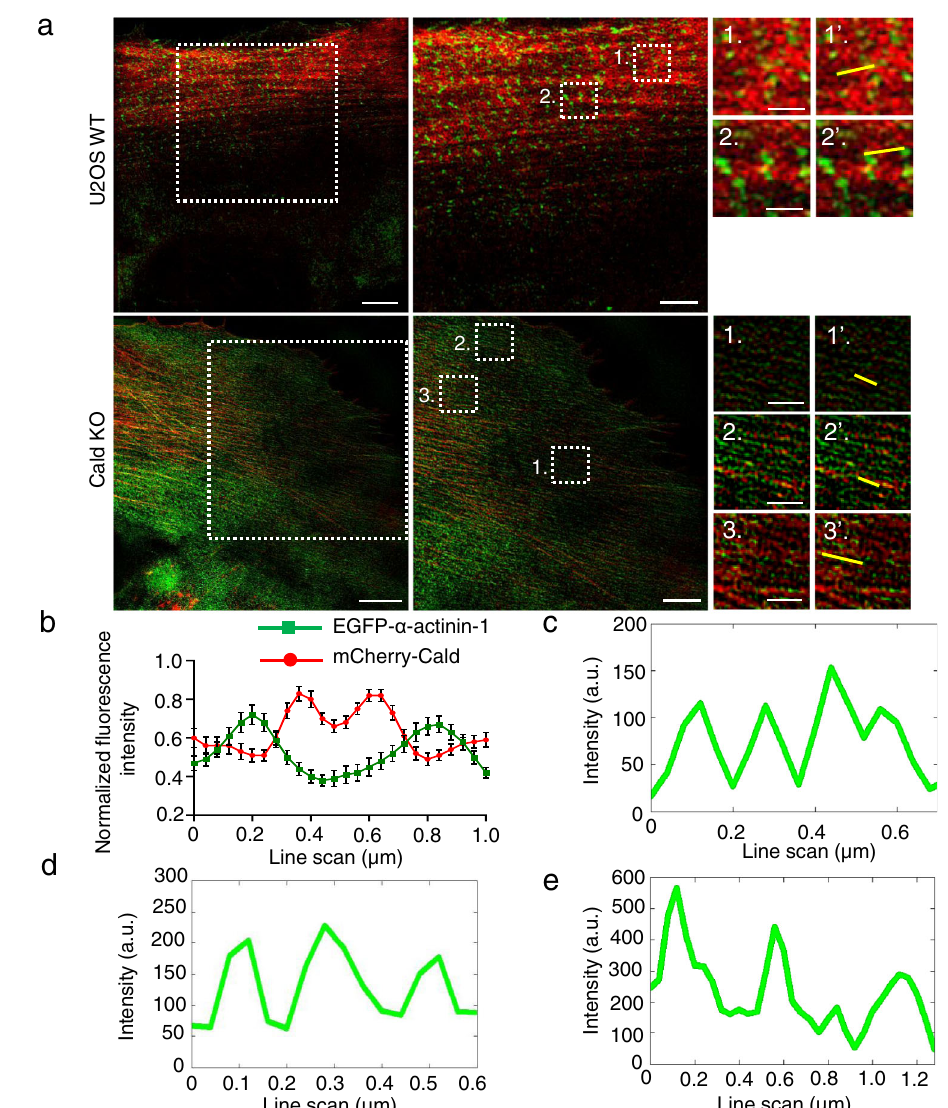
Fig. 7 | Effects of Caldesmon depletion on α -actinin localization along stress fi bers. a Representative SIM image of a wild-type U2OS cell (top row) expressing GFP- α -actinin (green) and mCherry-Caldesmon (red). White boxes represent the magni fi ed regions. The thin yellow lines in magni fi ed images 1 ’ and 2 ’ represent examplesofstress fi berregionsthatwereusedforthelineplotanalysisof α -actinin/ Caldesmonco-localization.ThebottomrowshowsrepresentativeSIMimagesfrom a Caldesmon KO cell expressing GFP- α -actinin (green) and stained with phalloidin for F-actin (red). The magni fi ed regions 1, 2, and 3 represent the localization of α -